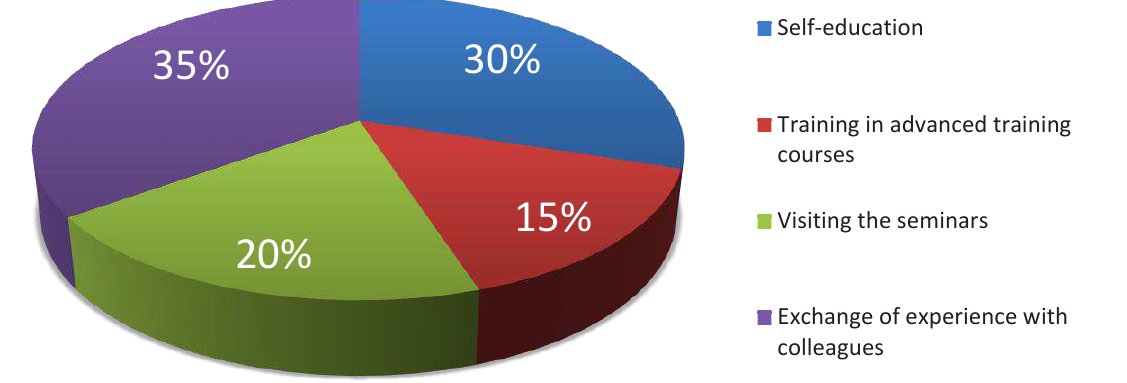
Figure 1. Knowledge sources of human resource management used by